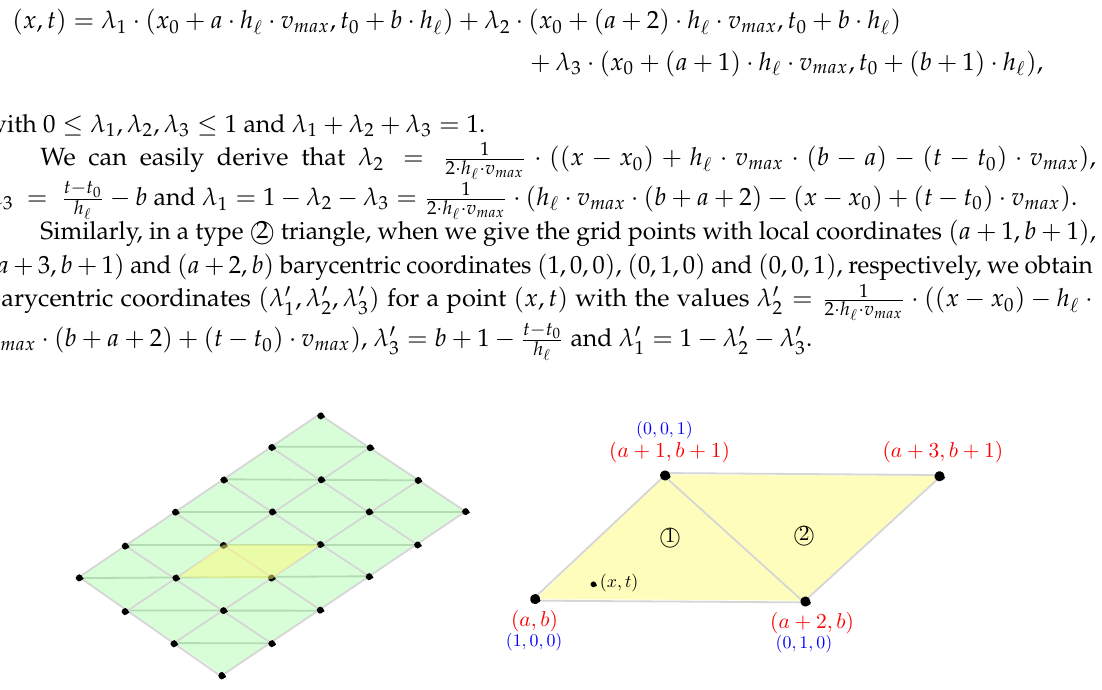
Figure 6. The division of a prism in triangles, on the left and the two types of triangles ( 1 (cid:13) and 2 (cid:13) ) in a prism and their barycentric coordinates, on the